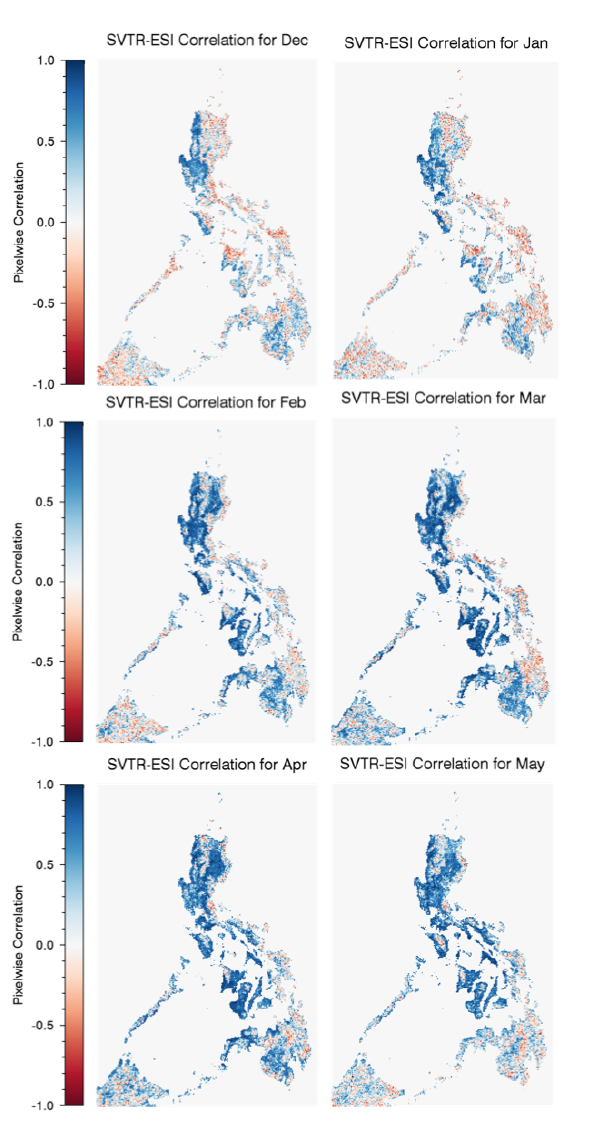
Figure 2. Correlation maps of SVTR and ESI during